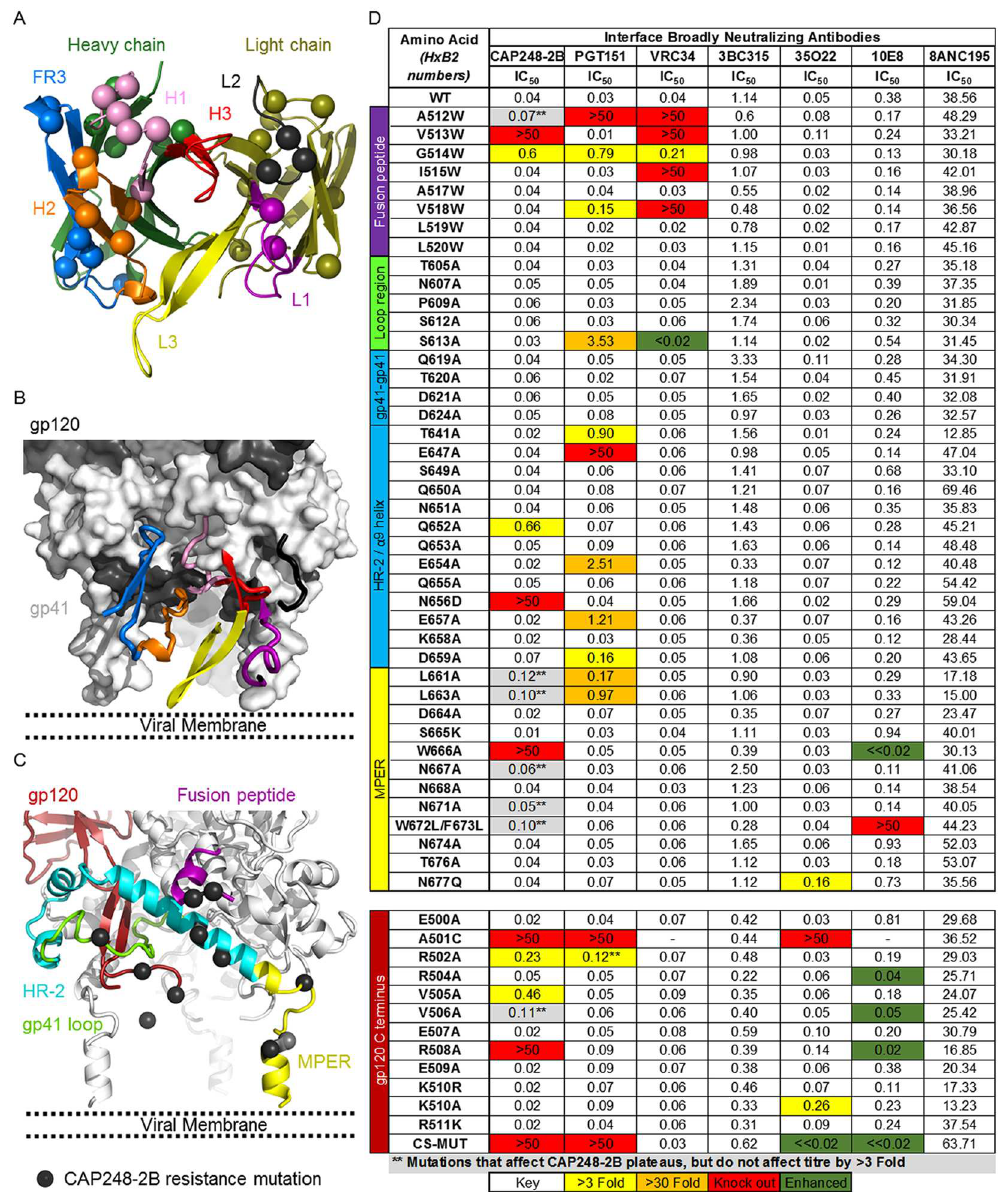
Fig 8. Fine mapping of the CAP248-2Bepitope. (A) Cartoonof the CAP248-2B paratope(shown as a mirror image of the docked model in B, and coloredas in Fig 3), showingamino acids that have affinity matured relativeto the predicted germlinegenes with main chain C α spheres. (B) A surface view schematic of gp41 (dark grey) and proximalregions in gp120 (light grey) showingthe predicted location of CAP248-2B CDRs and FW3, colouredas in A. The approximate locationof the viral membraneis indicated. (C) The envelopetrimer is shown in cartoon view with the viral membraneestimated as in B. Regionsof Env predictedto form part of the CAP248-2B epitopeare colouredand labelled.Point mutants shown to significantly affect CAP248-2B neutralizationare shown with black spheres. (D) Table showingneutralization IC 50 titers for CAP248-2B,PGT151, VRC34, 3BC315,35O22, 10E8, and 8ANC195againstCAP45 and variousmutants. The location of each mutant in either gp41 or the gp120 C terminus is shown on the left and colouredas in C. Fold effects on IC 50 are colored, with warmer colours to indicated increasingly